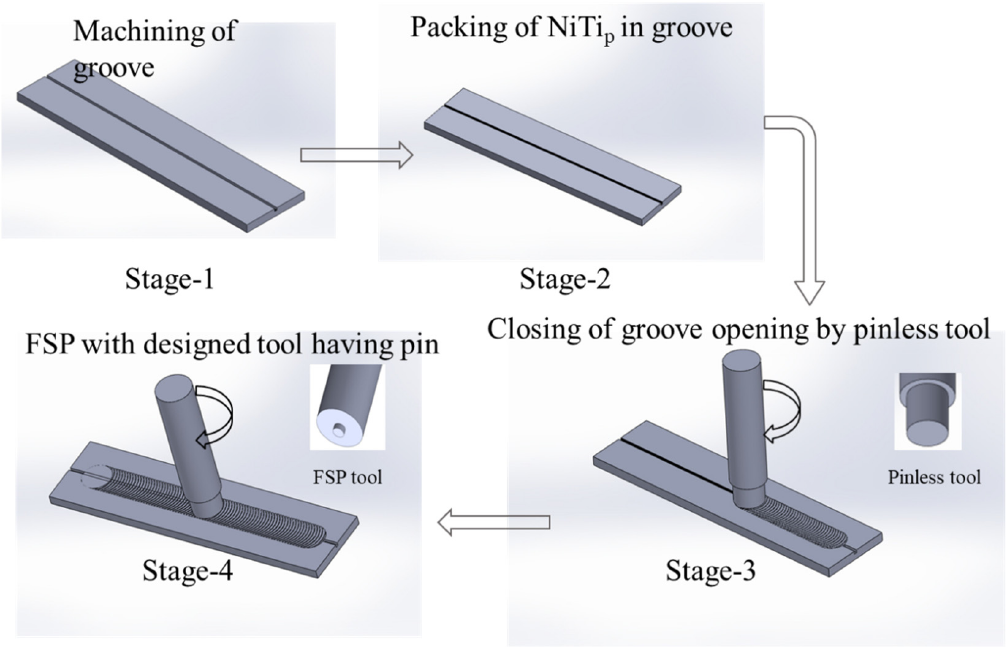
Figure 2. Schematic diagram showing the stages involved in the composite fabrication via friction stir processing (FSP).